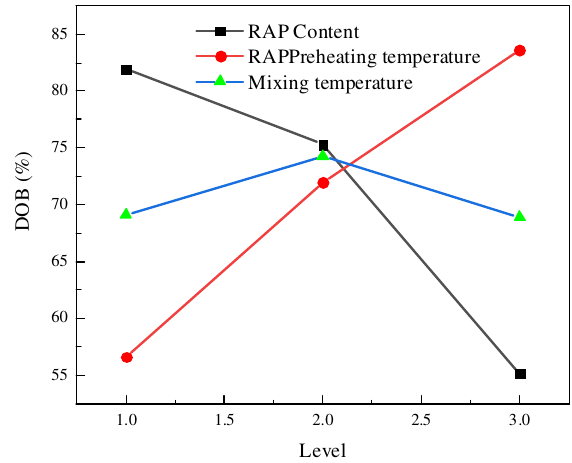
Figure 3. Levels and DOB results changing trend.